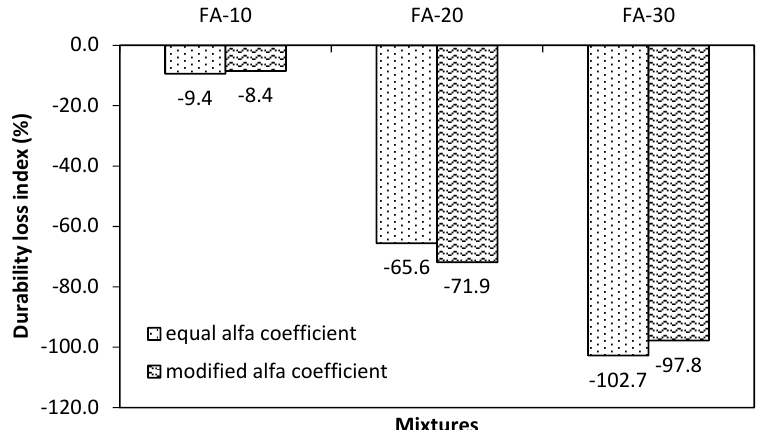
Figure 14. Calculated values of the durability index for single mixtures.